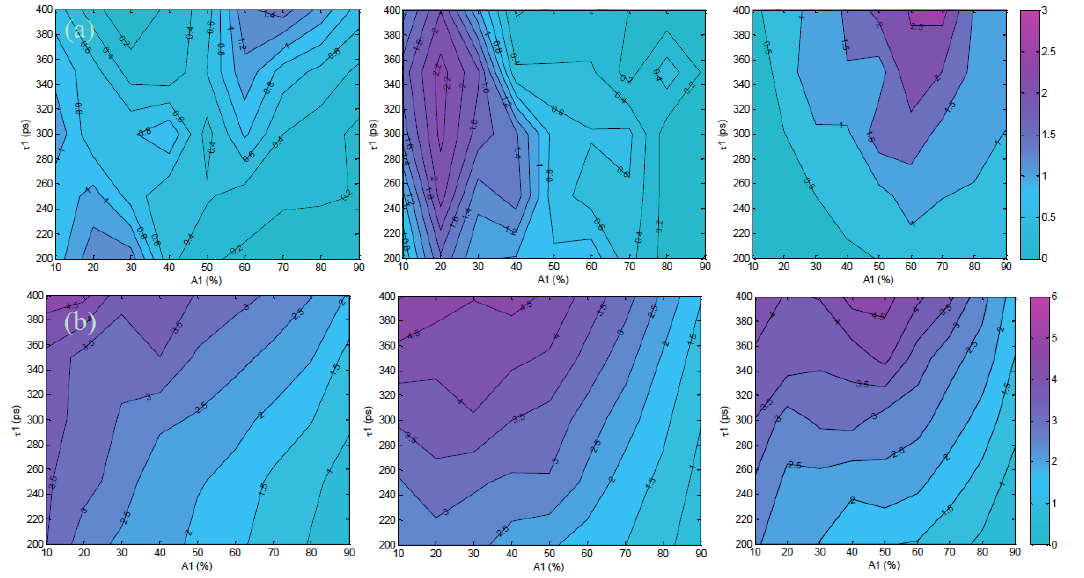
Figure 2. Trends in ( a ) absolute error and ( b ) standard deviation for estimation of A 1 under optimal conditions (maximum of the TPSF at 3000 photons) and 300 ps, 600 ps, 1000 ps